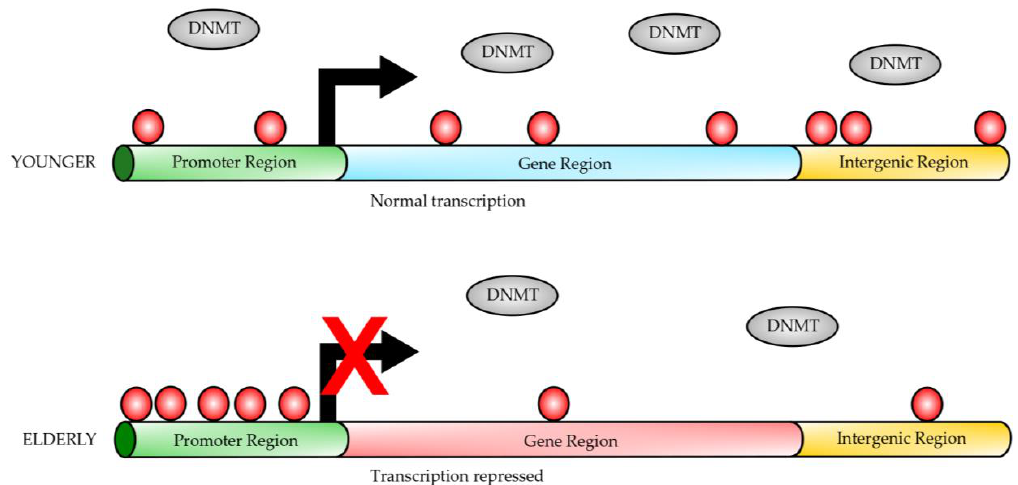
Figure 1. Gene DNA methylation during aging. In younger individuals, the gene promoters have a lower degree of DNA methylation (red circles) than in elderly individuals, while the gene bodies are highly methylated (red circles). On the contrary, elderly individuals have gene promoters heavily methylated (red circles); however, the gene bodies are hypomethylated. Transcription initiation is inhibited by DNA methylation at the gene promoters from elderly individuals. Dynamic DNA methylation occurs at CpG sites on the gene promoters or gene bodies. DNA methylases (DNMTs) carry out methylation of CpG sites, which protein factors or non-coding RNAs can regulate. This figure was modified from reference